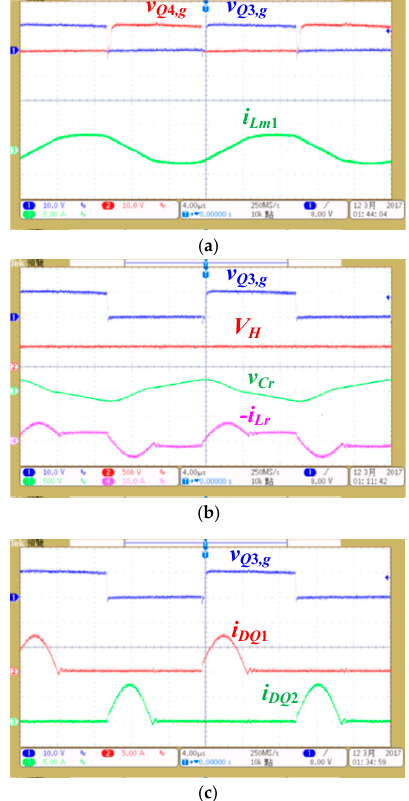
Figure 10. Test results of Q 2 under ( a ) V H = 350V and 20% load [ v Q 2 ,g : 10 V/div; v Q 2 ,d : 200 V/div; i Q 2 : 2 A/div; time: 4 µs/div] ( b ) V H = 350 V and 100% load [ v Q 2 ,g : 10 V/div; v Q 2 ,d : 200 V/div; i Q 2 : 5 A/div; time: 4 µs/div] ( c ) V H = 400V and 20% load [ v Q 2 ,g : 10 V/div; v Q 2 ,d : 200 V/div; i Q 2 : 2 A/div; time: 4 µs/div] ( d ) V H = 400 V and 100% load [ v Q 2 ,g : 10 V/div; v Q 2 ,d : 200 V/div; i Q 2 : 5 A/div; time: 4 µs/div].